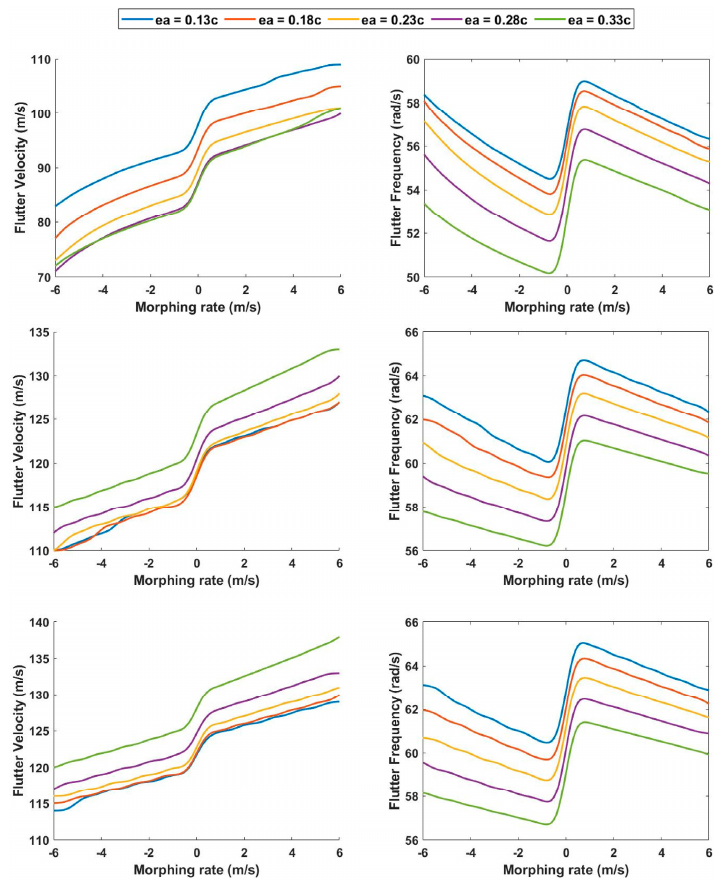
Figure 9. Left: Flutter Velocity vs. morphing rate for span of 6.858 m. Right: Left: Flutter Frequency vs. morphing rate for span of 6.86 m. Top : GJ = 1% of baseline wing. Middle : GJ = 10% of baseline wing. Bottom : GJ = 100% of baseline wing.